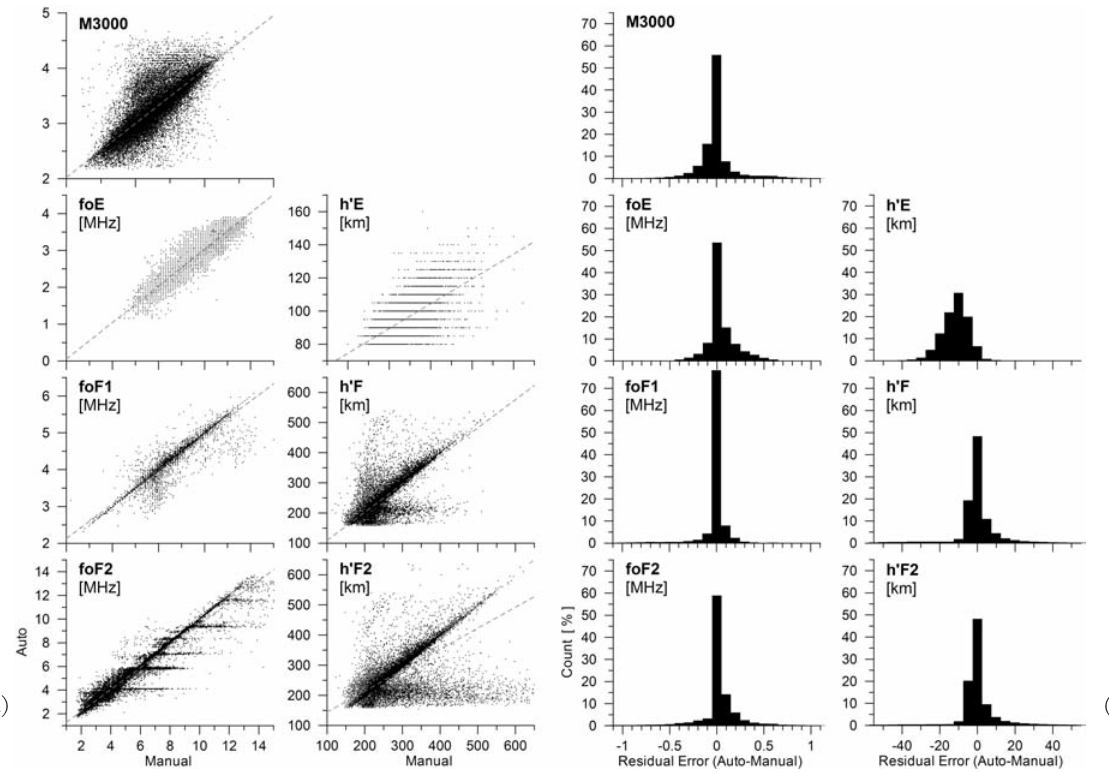
Figure 5. Comparisons between the automatically and manually scaled ionospheric characteristics during the period of 2002 to 2008. (a) Scatter plots of the residual errors (automatically versus manually scaled values). (b) Histograms of the residual errors.